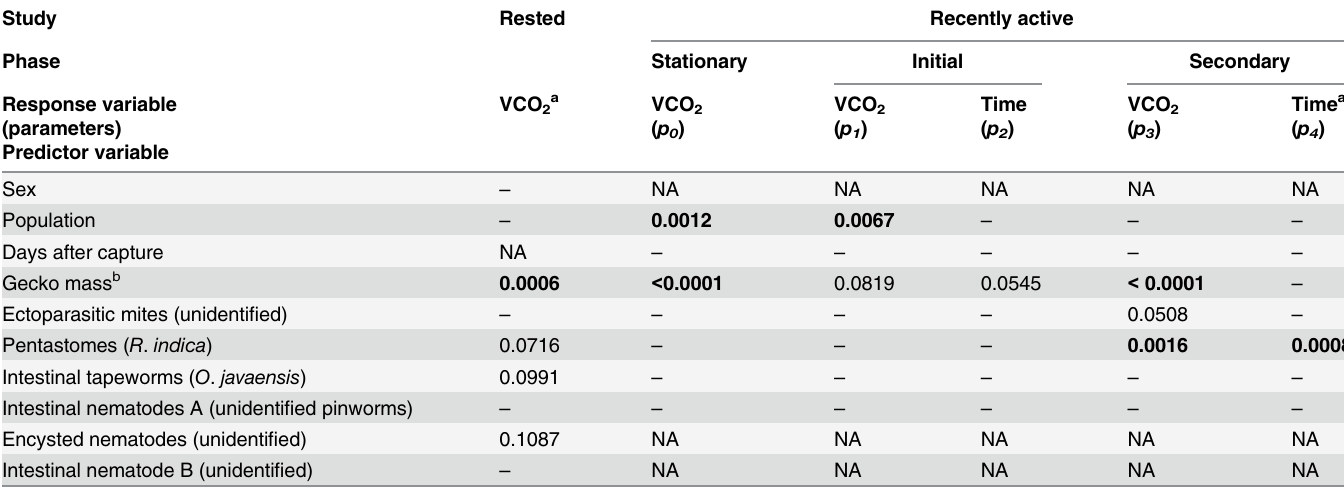
Table 2. Effect of explanatory variables on VCO 2 found in minimal models obtained by an automated stepwise backward procedure based on AIC values for rested geckos ( n = 48) and recently active geckos ( n = 70). The same explanatory variables were used to assess time to recovery in recently active geckos. The excluded explanatory variables by the automated procedure are denoted with a dash symbol. The P-values associated with significant predictors are in bold. F-values for these tests are reported in Table C in S2